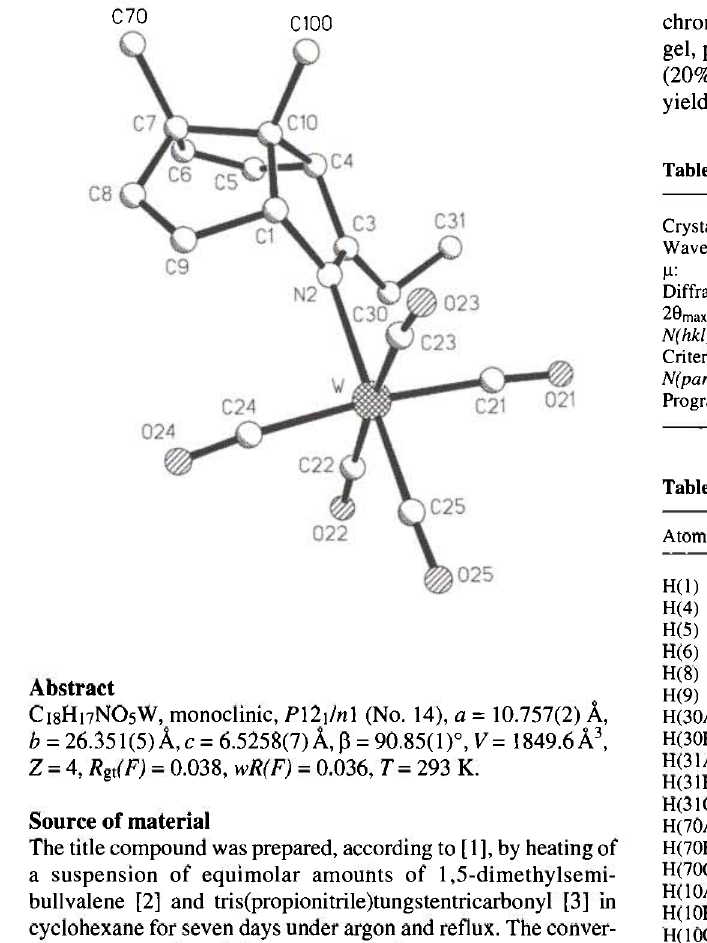
chromatography of the dark brown-black crude product (silica gel, petroleum ether/ethyl acetate, 95:5) afforded a yellow solid (20% yield, mp 487 K). Recrystallization from the same solvent yielded transparent, yellow crystals.